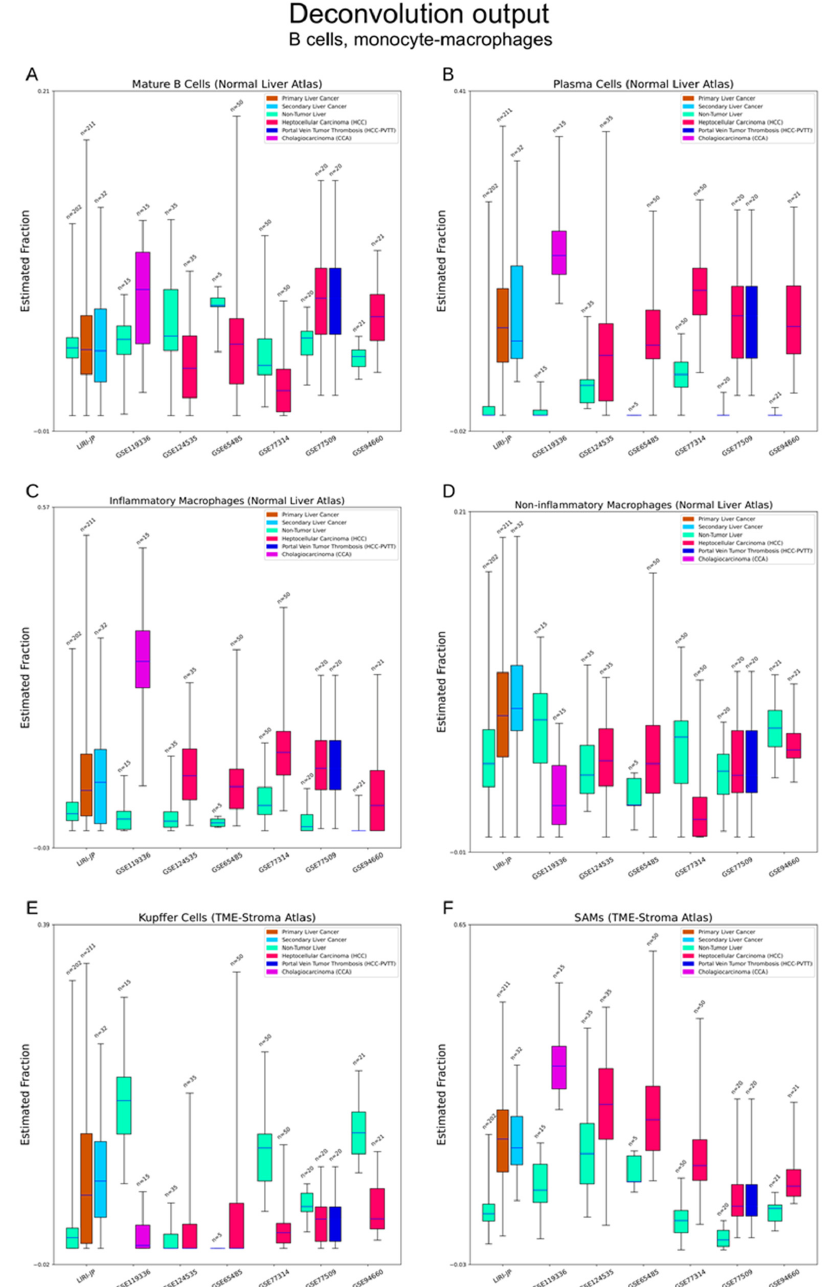
Figure 5. Deconvolution output—B cells, monocyte–macrophages. ( A , B ) Estimation of B cells. Plasma B cells can rarely be detected in normal livers but common in liver cancers. ( C – F ) Estima- tion of macrophages. The Normal Liver atlas separates macrophages into inflammatory and non- inflammatory subtypes. The TME-Stroma atlas identified Kupffer cells, scar-associated macrophages (SAMs) and tissue macrophages (TMs, Figure 6E). Overlap of cell type trees may exist between the two atlases. Increase of inflammatory macrophages can be seen in liver cancers. SAMs are a pathological variant of macrophages and participate in the process of liver fibrosis. Their elevation can be seen in liver